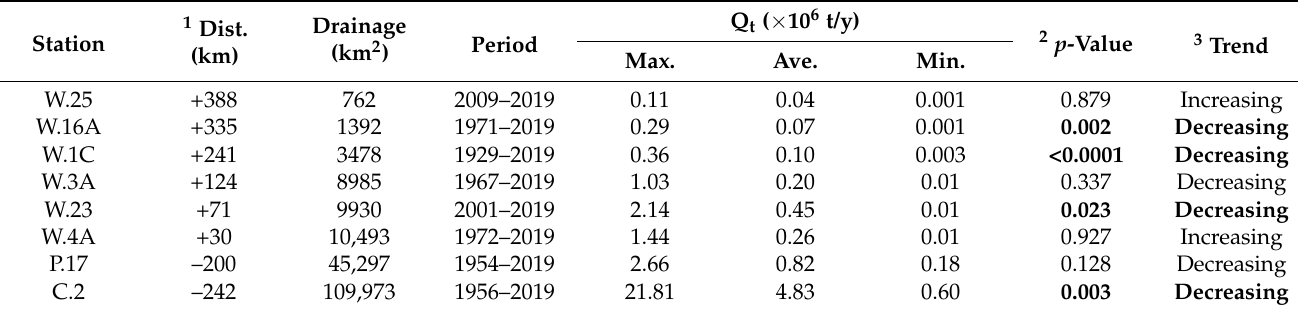
Table 3. Summary of estimated total sediment load (Q t ) at RID hydrological stations on the Wang River and Station C.2 on the Chao Phraya River (significance accepted at p -value <